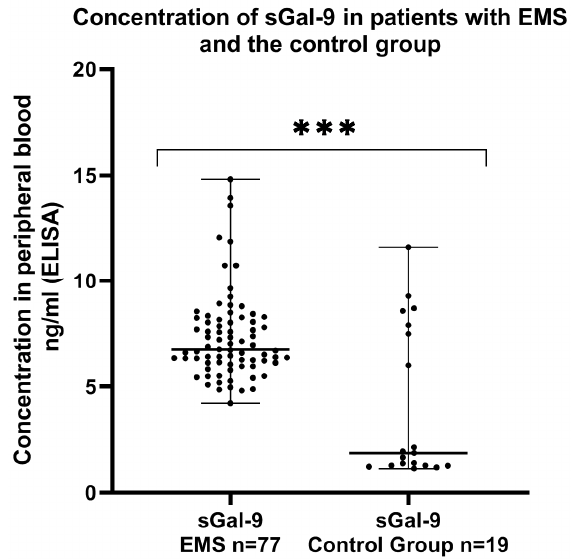
Figure 5. Levels of sGal-9 (ng/mL) in the plasma of patients with endometriosis and control group. The median value with the following signs indicate statistically significant differences: *** p < 0.001.